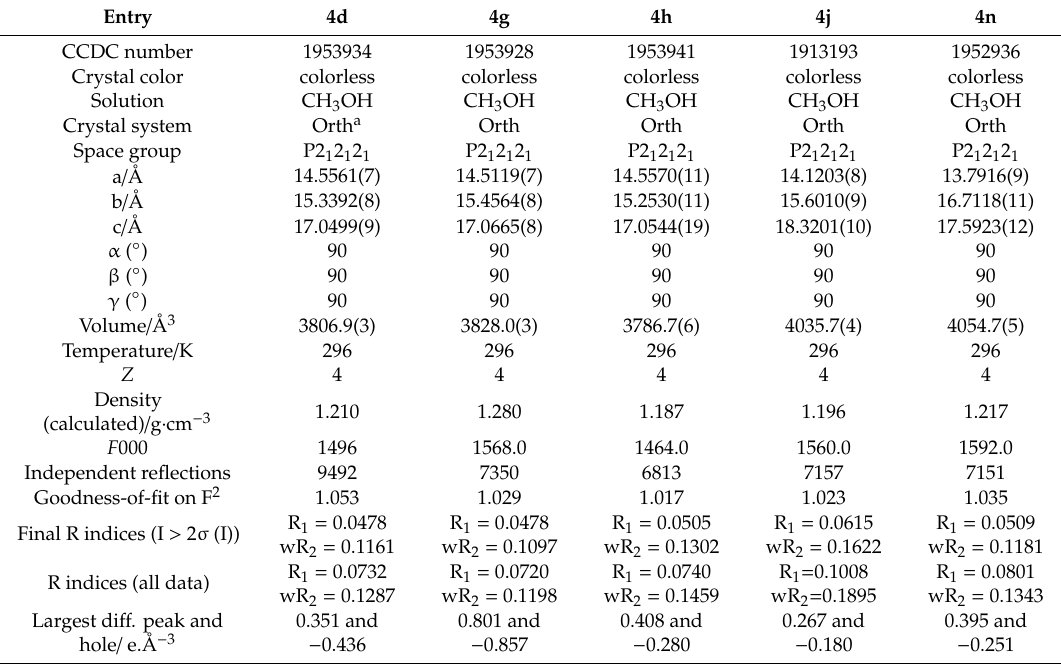
Table 1. Details for the crystal structure determinations of compounds 4d , 4g , 4h , 4j , and 4n .